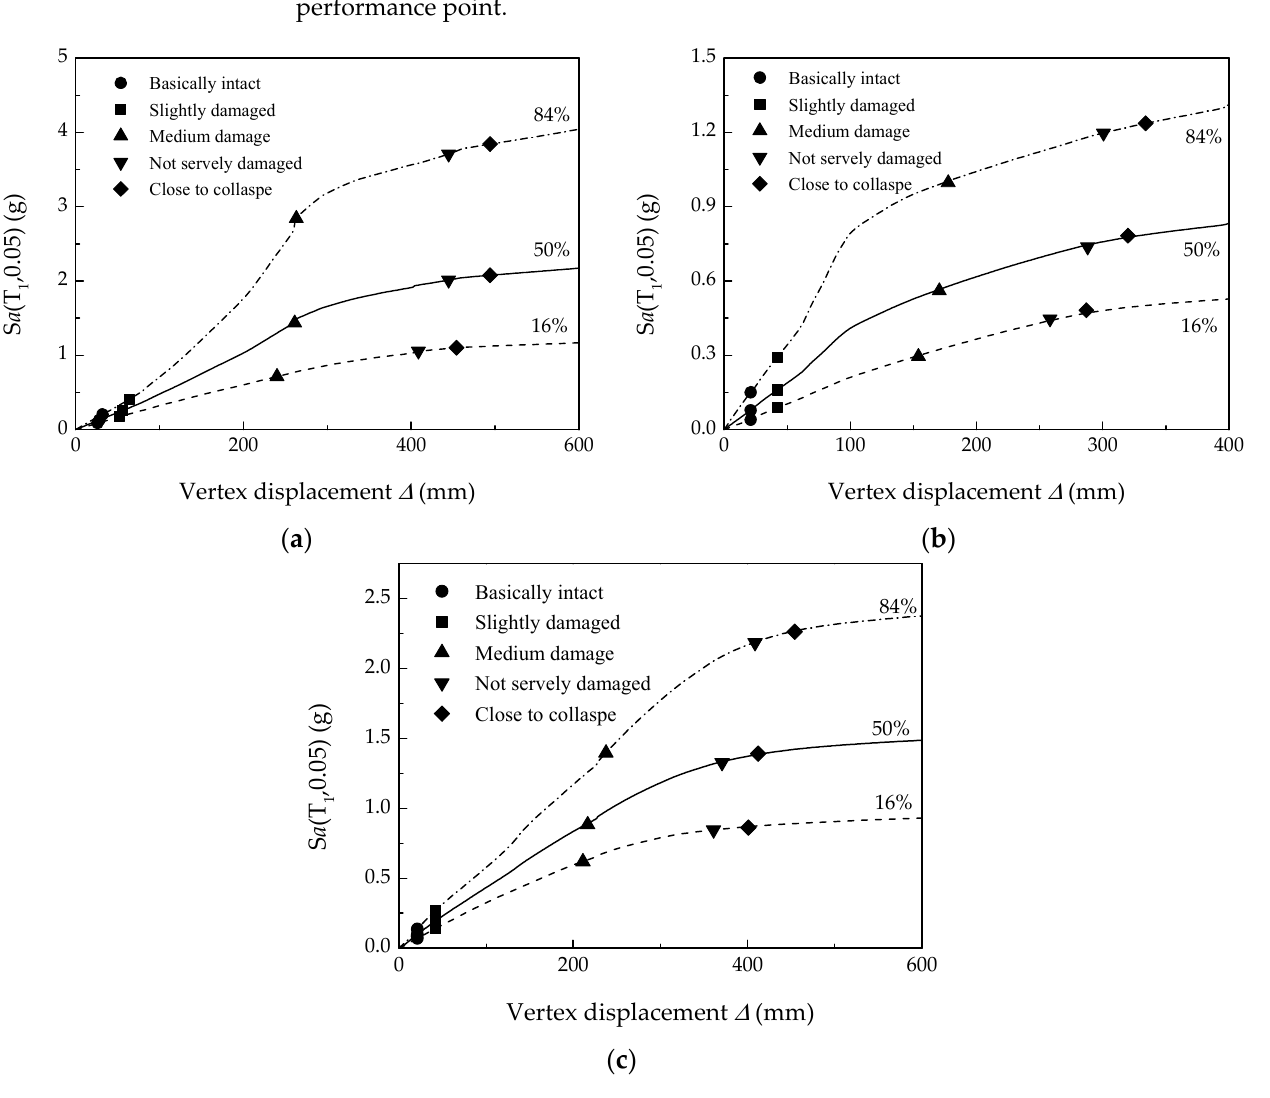
Figure 17. Determination of the performance points on the IDA curve of each frame. ( a ) RC frame F0; ( b ) Frame with RC short columns FS1; ( c ) Frame with ECC short columns FS2.